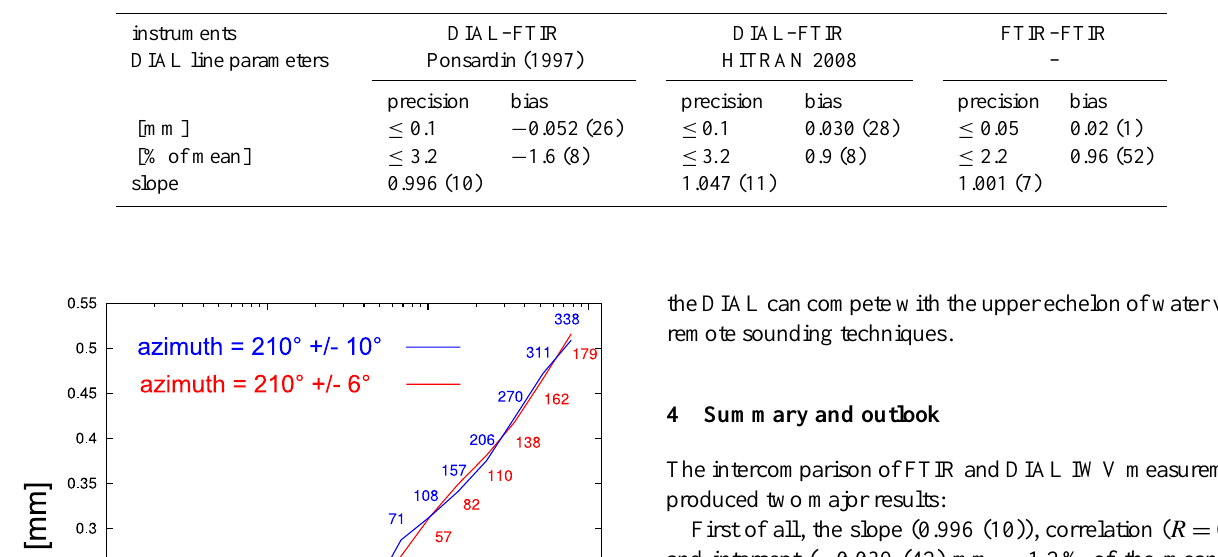
Table 2. Intercomparison results of DIAL (two sets of line parameters) versus FTIR and FTIR versus FTIR (side-by-side experiment, Sussmann et al., 2009).